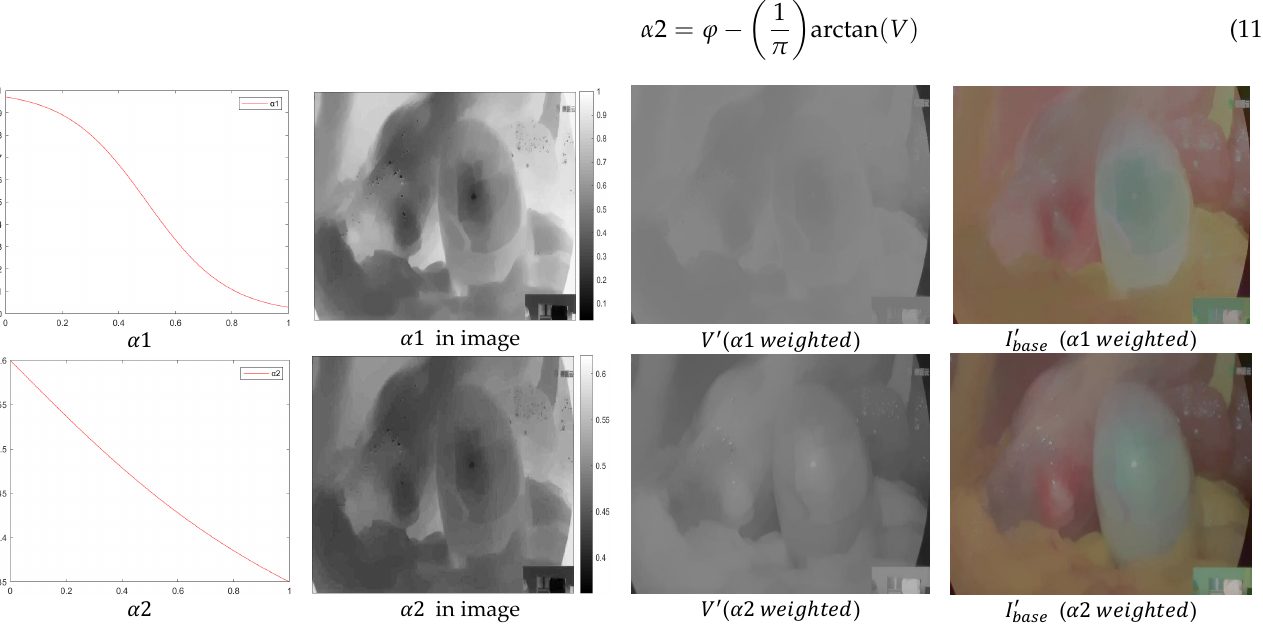
Figure 5. 𝛼1 and 𝛼2 function plots, weighting plots, and stretching effect plots. 𝜑 was set to 0.6 Figure 5. α 1 and α 2 function plots, weighting plots, and stretching effect plots. ϕ was set to 0.6 in the in the endoscopic images (see experimental analysis). endoscopic images (see experimental